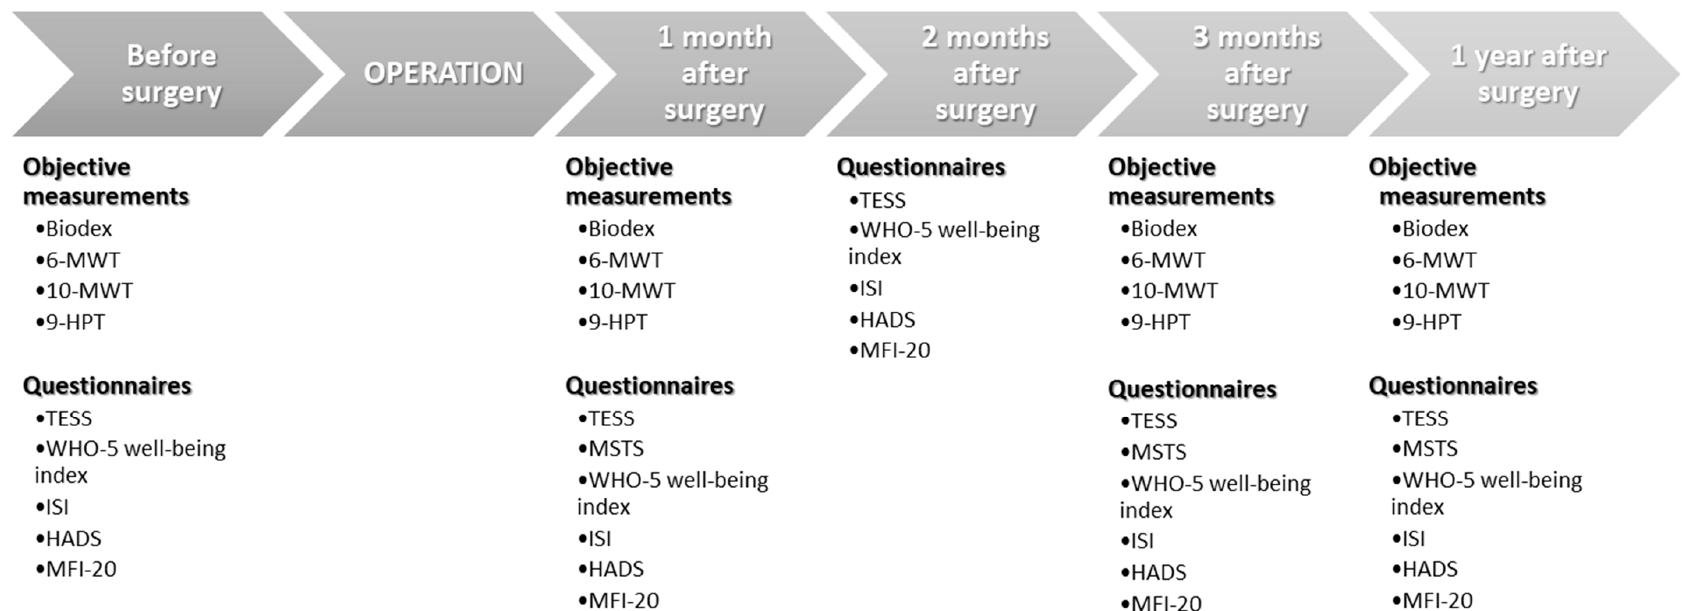
Figure 1. Time points for each measurement in the study.